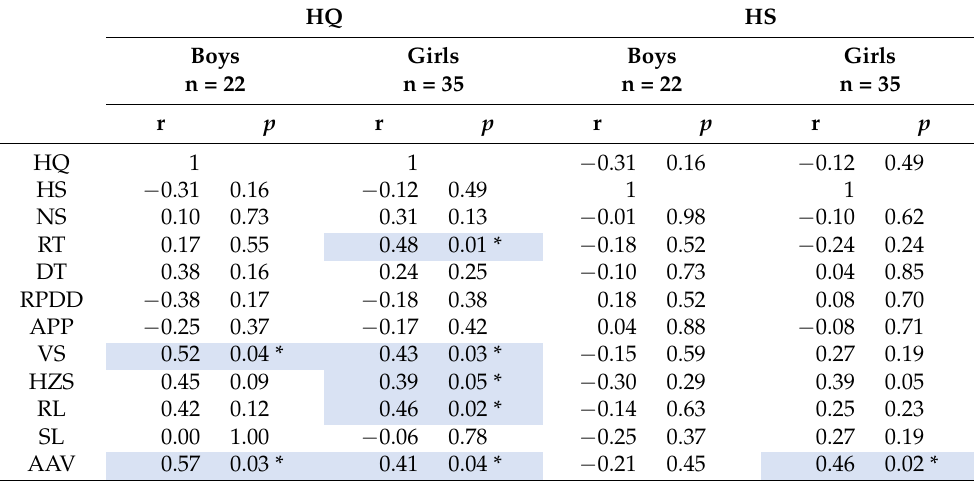
Table 3. Correlations between the handwriting product and the process characteristics for each gender group. HQ